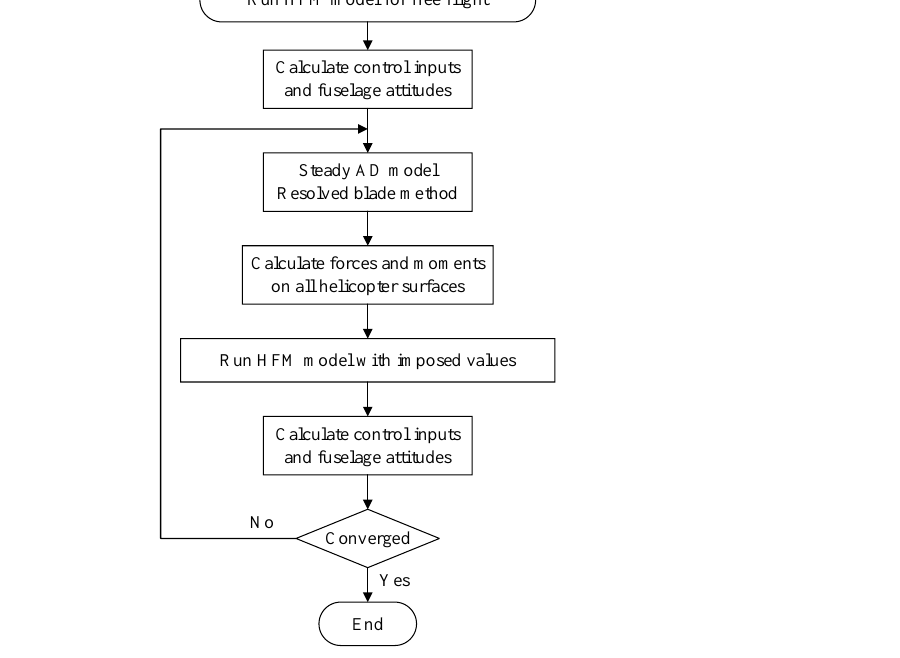
Table 1. Main parameters of LPD17 ship and SA365 helicopter.